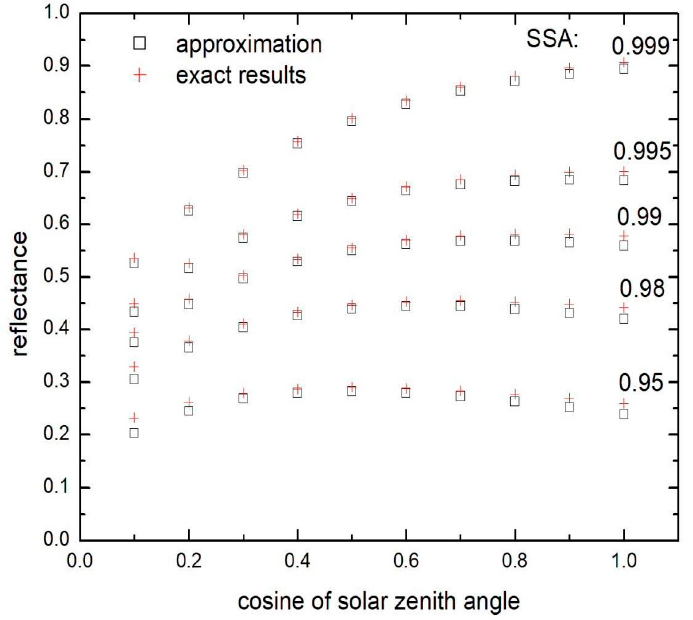
Figure 2. The dependence of the snow reflectance calculated using Henyey-Greenstein phase function at g = 0.75 (semi-infinite snow case) and various values of single scattering albedo (SSA) as a function of the solar zenith angle at the nadir observation (exact results: crosses, approximation: boxes).